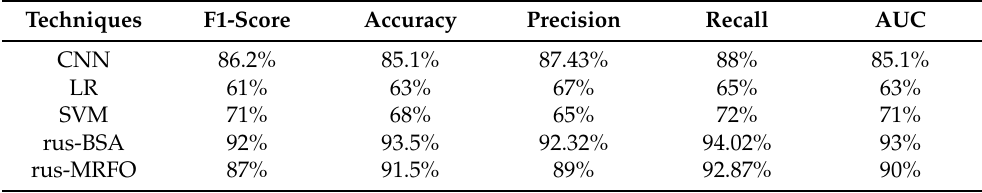
Table 3. Performance metrics score.